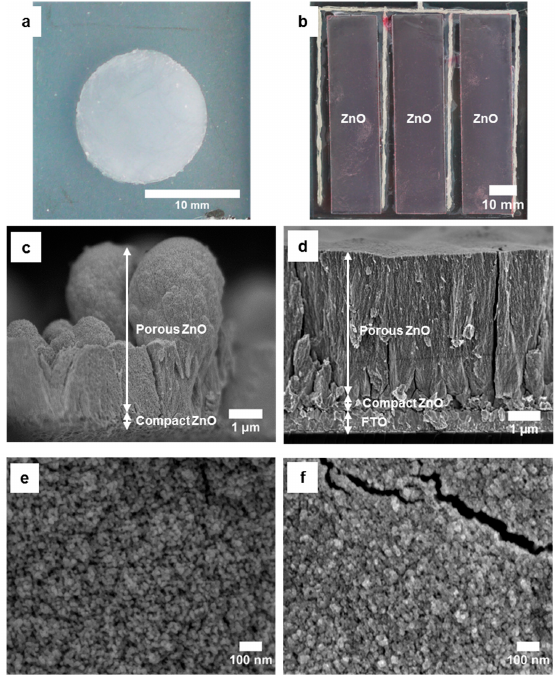
Figure 3. Morphology of ZnO films electrodeposited on FTO-glass substrates in the RDE setup (deposition of compact layer for 10 min and of porous layer for 45 min) and in the miniplant setup (deposition of compact layer for 20 min and of porous layer for 120 min): Photographs of ZnO films after deposition in the RDE setup ( a ) and miniplant setup ( b ); scanning electron microscopy (SEM) cross section images of compact and porous ZnO film deposited in the RDE setup ( c ) and miniplant setup ( d ); SEM top view images of compact and porous ZnO film deposited in the RDE setup ( e ) and miniplant setup ( f ).